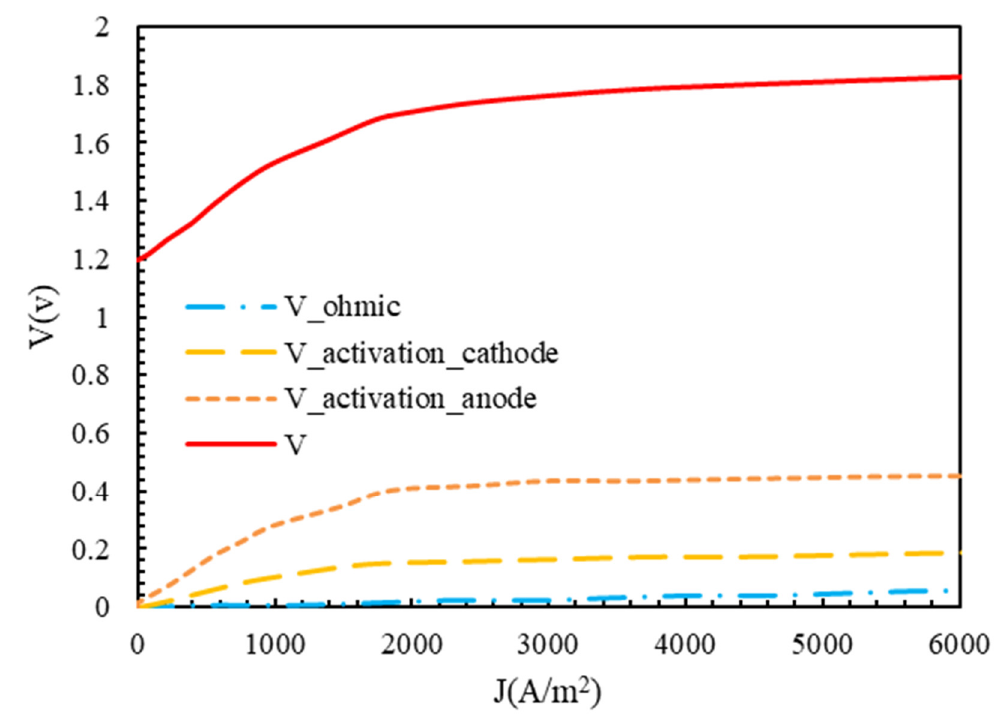
Figure 3. Polarization of polymer membrane electrolyzer.